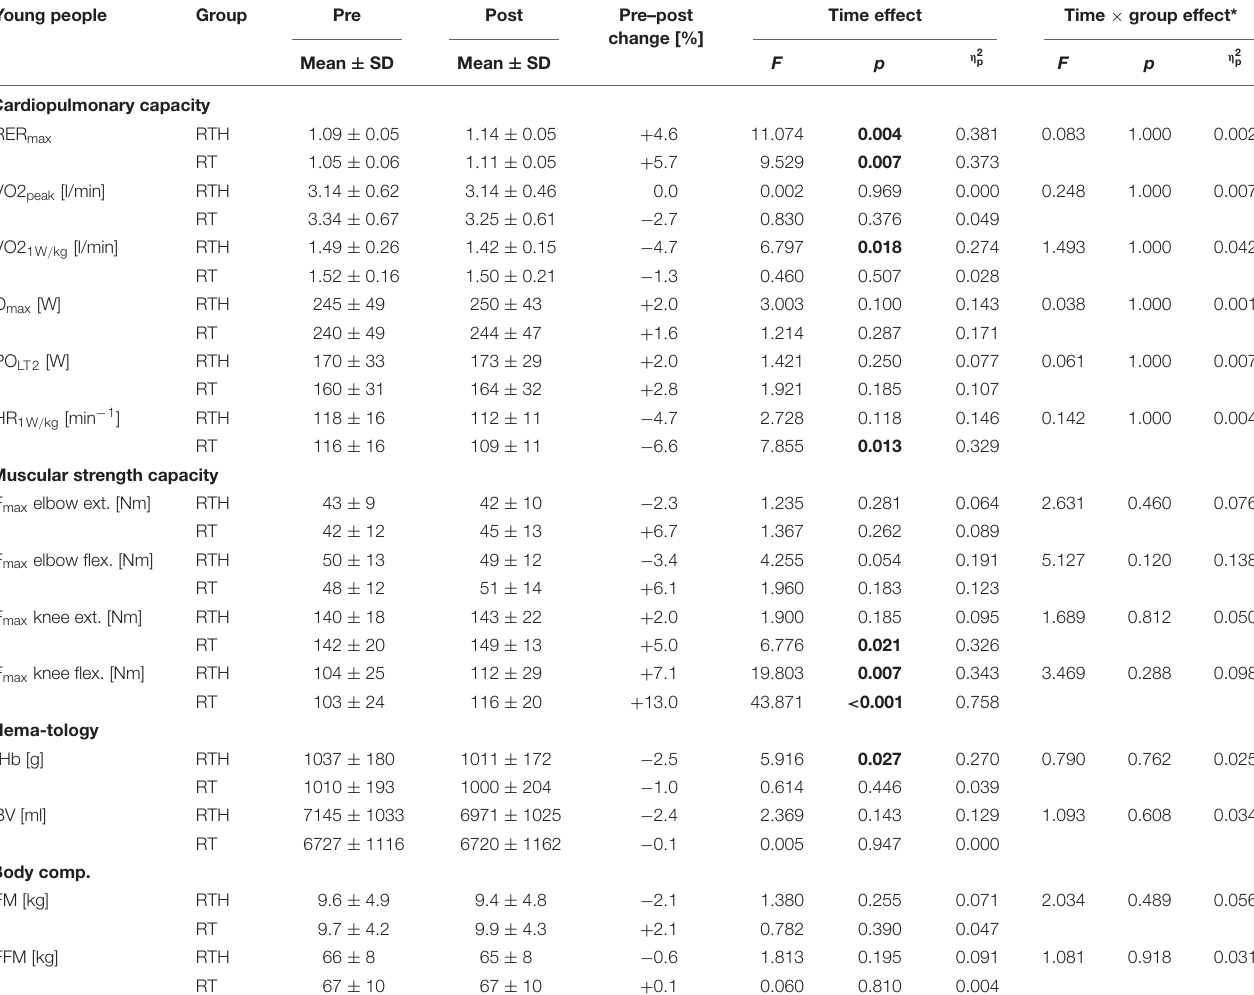
TABLE 2 | Pre–post results of the cardiopulmonary capacity, muscular strength capacity, hematological parameters, and body composition of the group RTH young (resistance training under hypoxia) and RT young (resistance training under normoxia). Young people Group Pre Post Pre–post